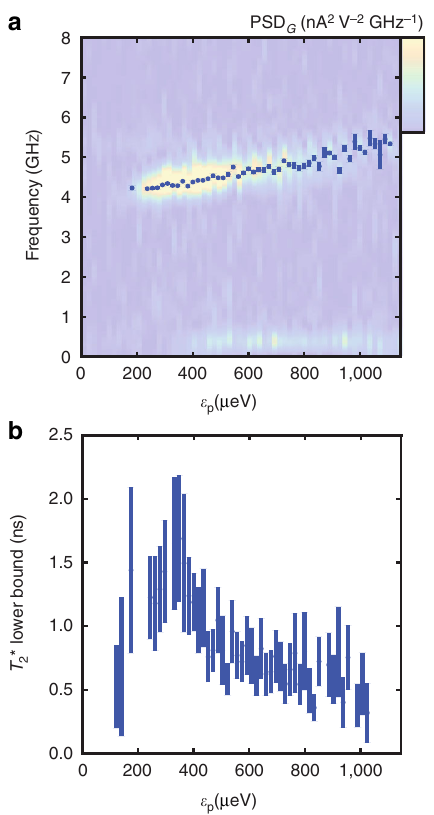
Fig. 4 Dispersion and decoherence. a The dispersion extracted from the transconductance data in Fig. 3a: The points are the frequencies extracted by applying a decaying sinusoidal fi t to each cut in ε p . The background is the magnitude of the power spectral density of those same cuts, calculated using Welsh ’ s method. b The extracted values of the decay time from the sinusoidal fi t: This value is actually a lower bound on phase decoherence time T (cid:5) . The decay time increases rapidly at fi rst and then begins to 2 decrease. The longest value directly observed is 1.5 ns. The height of the lines in both a and b indicates the 1.5- σ standard errors derived from the numerically estimated covariance energy of singlet/triplet-like states. However, in hybrid qubits, which tend to be guided by Hamiltonians where 2 Δ 1 , 2 Δ 2 < δ , the frequency approaches a minimum close to the detuning line.